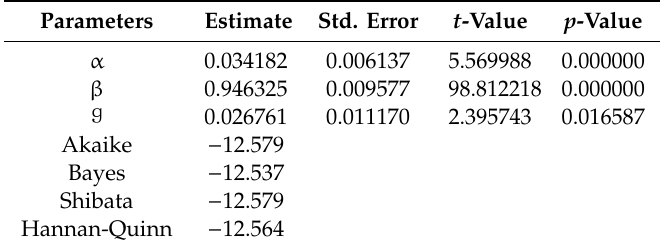
Table A3. Parameter Estimates of China’s Islamic-conventional ADCC-GARCH